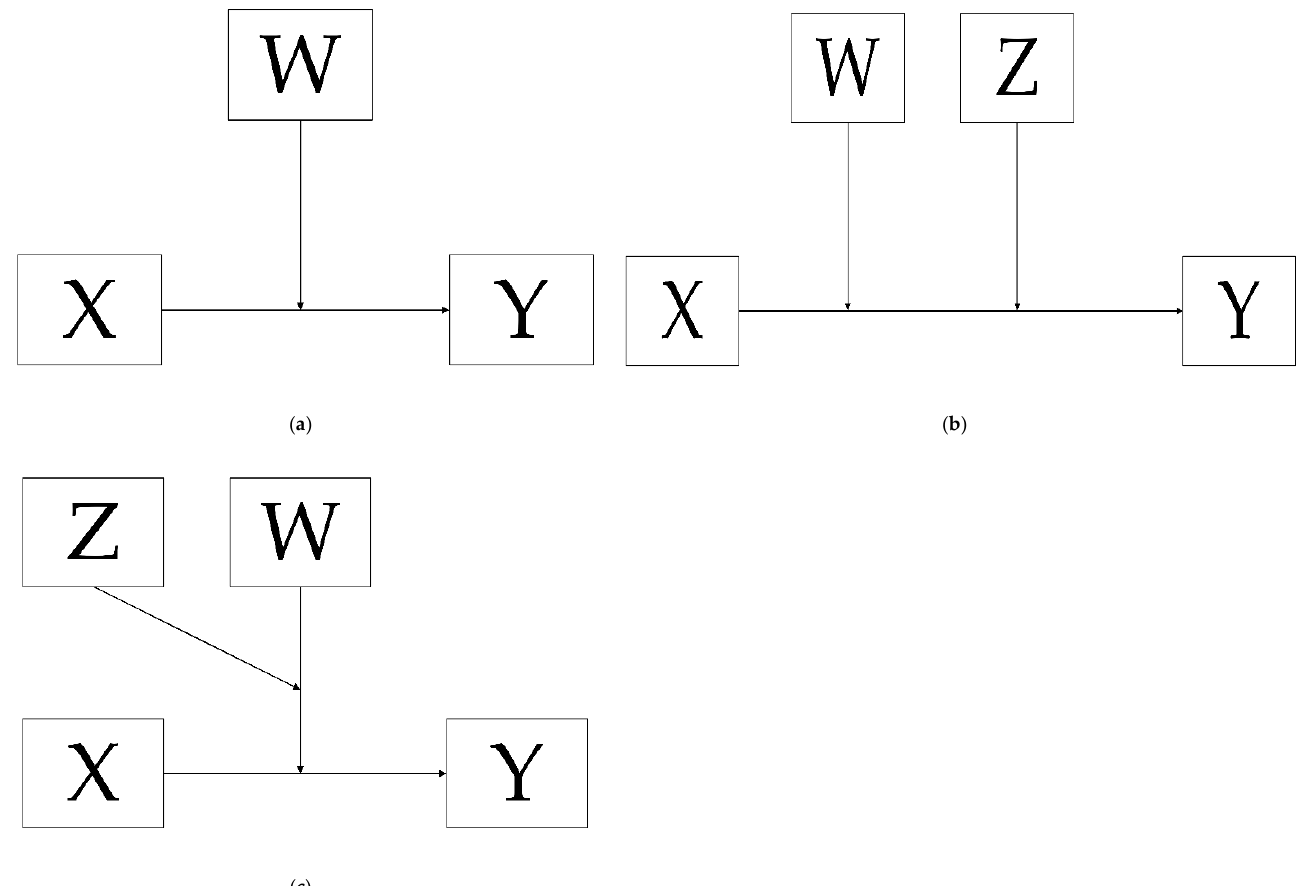
Figure 1. Conceptual diagram of three different moderation models, where X = BDNF rs6265 and Y = depressive symptoms. In addition, ( a ) W = childhood stress and physical activity; ( b , c ) W = child- hood stress and Z = physical activity.